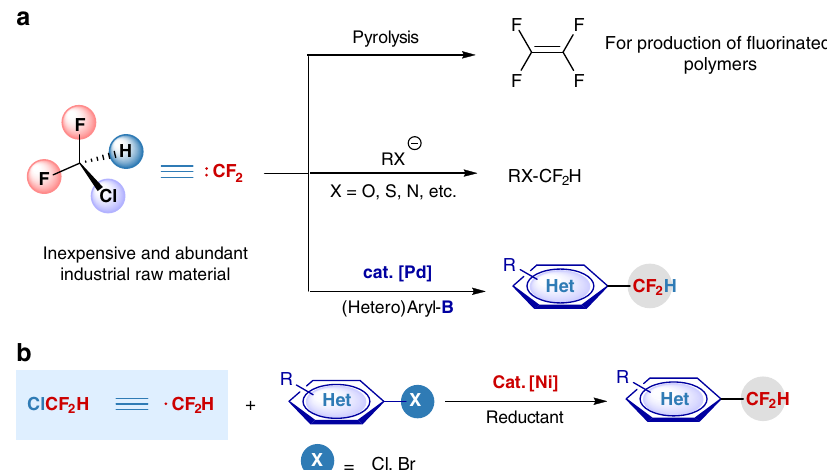
Fig. 1 Strategies in activation of ClCF 2 H. a Previous work, activation of ClCF 2 H via a di fl uorocarbene pathway. b This work, a new activation of ClCF 2 H through a di fl uoromethyl radical